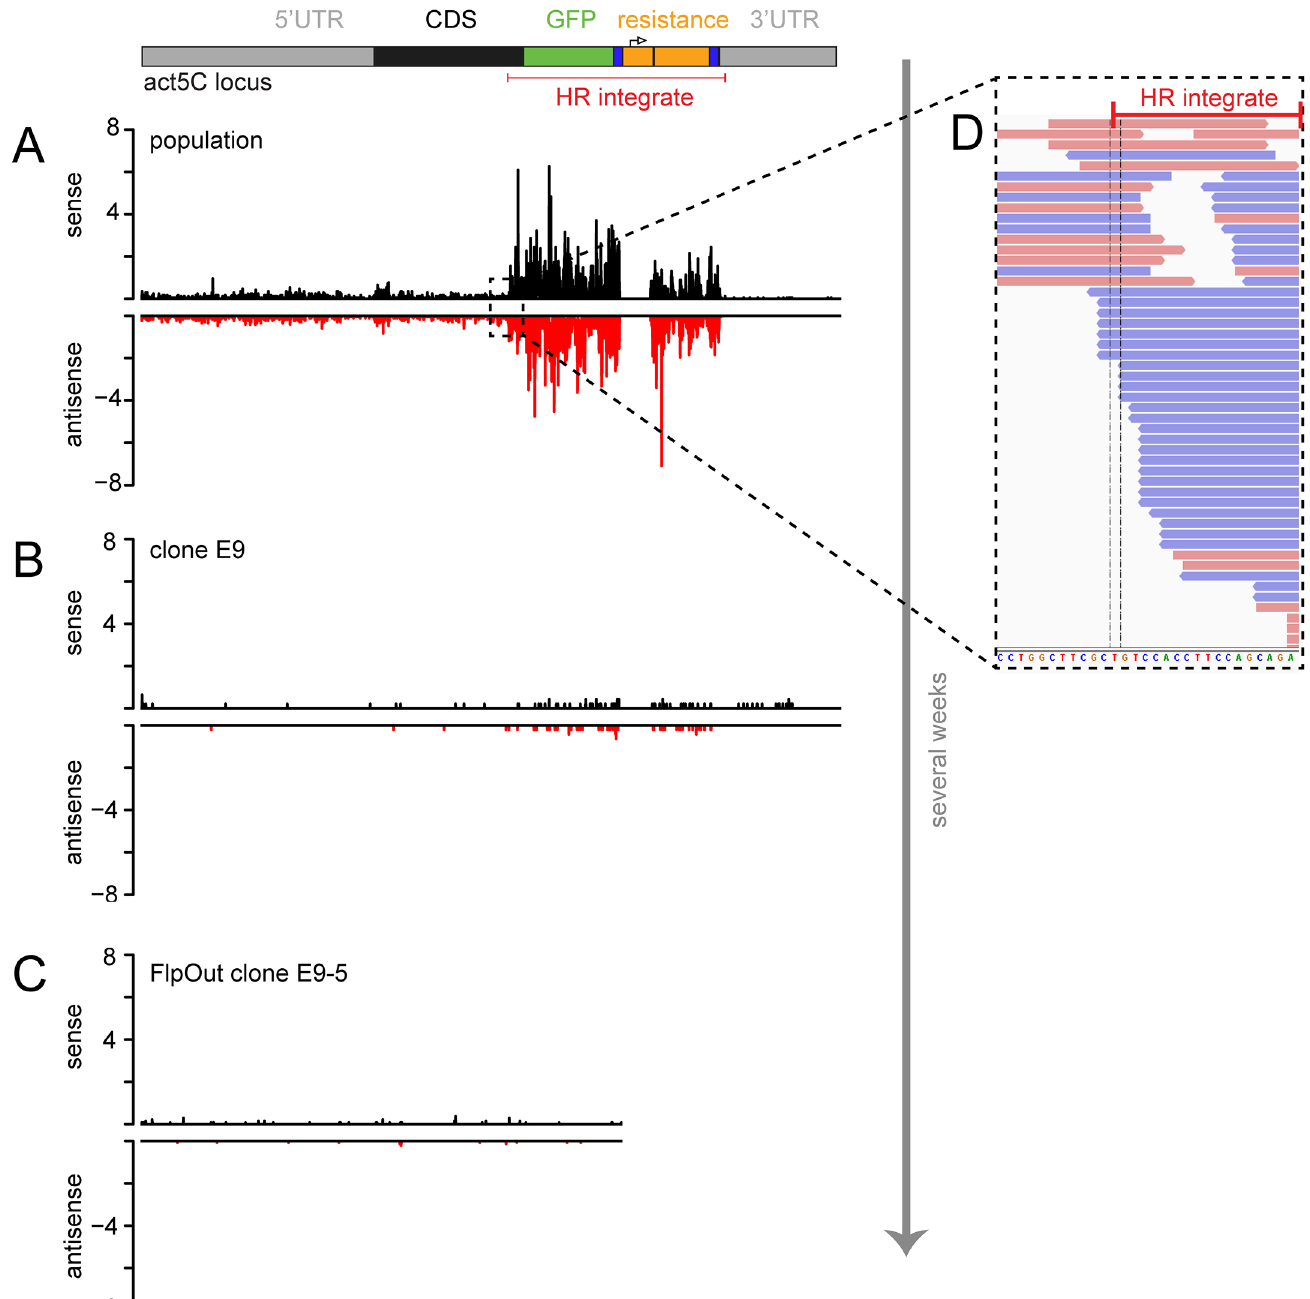
Fig 2. Profiling of siRNAs after genome editing by deep sequencing at the act5C locus. The siRNA distribution along the modified act5C locus was determinedbat single nucleotideresolution and normalized to the number of genome-matching reads in each library. The graphsdepict the sense (black) and antisense(red) matchingreads as reads per million of genomematching19–25 nt reads in the respectivelibrary. Shown are the sequencing traces for the initial drug-selectedpopulation (A), the singlecell clone E9 (B) and the respectiveFlpOut clone E9-5 (C) as representive examples. The functionalregionsof the locus (drawn to scale) are depicted at the top; the HR donor is annotatedin red. Reads derived from the copia promotor sequencewere removedprior to mappingthe remainingreads on the construct. Thus, the corresponding region is “masked”. The box (D) shows the magnification of the transition betweenthe endogenoussequenceand the HR integrate (annotated red bar). Junction-spanningsiRNA reads in sense (red) and antisense(blue) orientationcan be detected.